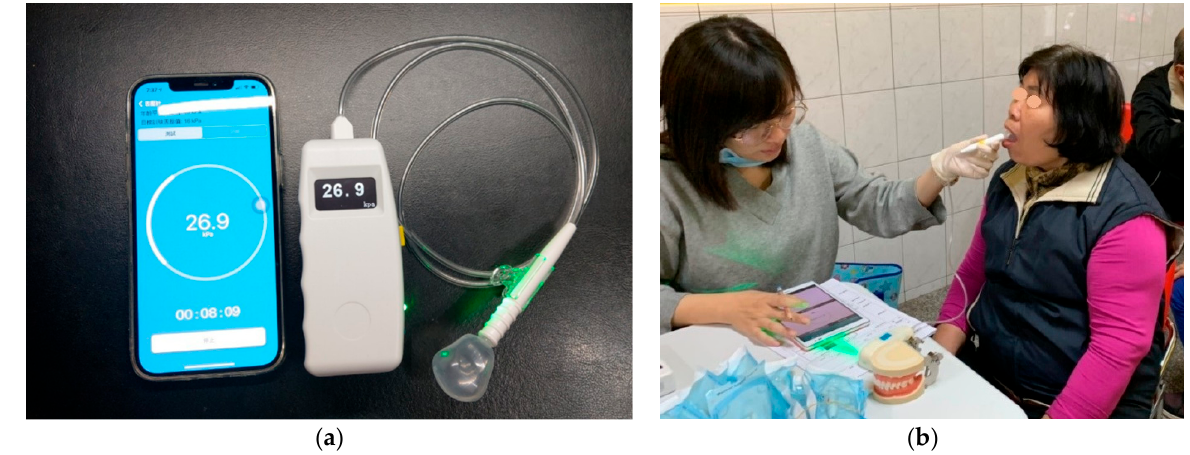
Figure 1. ( a ) A tongue pressure measurement device with wireless mobile application control function and a disposable oral positioning mouthpiece. ( b ) The tongue pressure device and its usage in the measurement of tongue pressure.